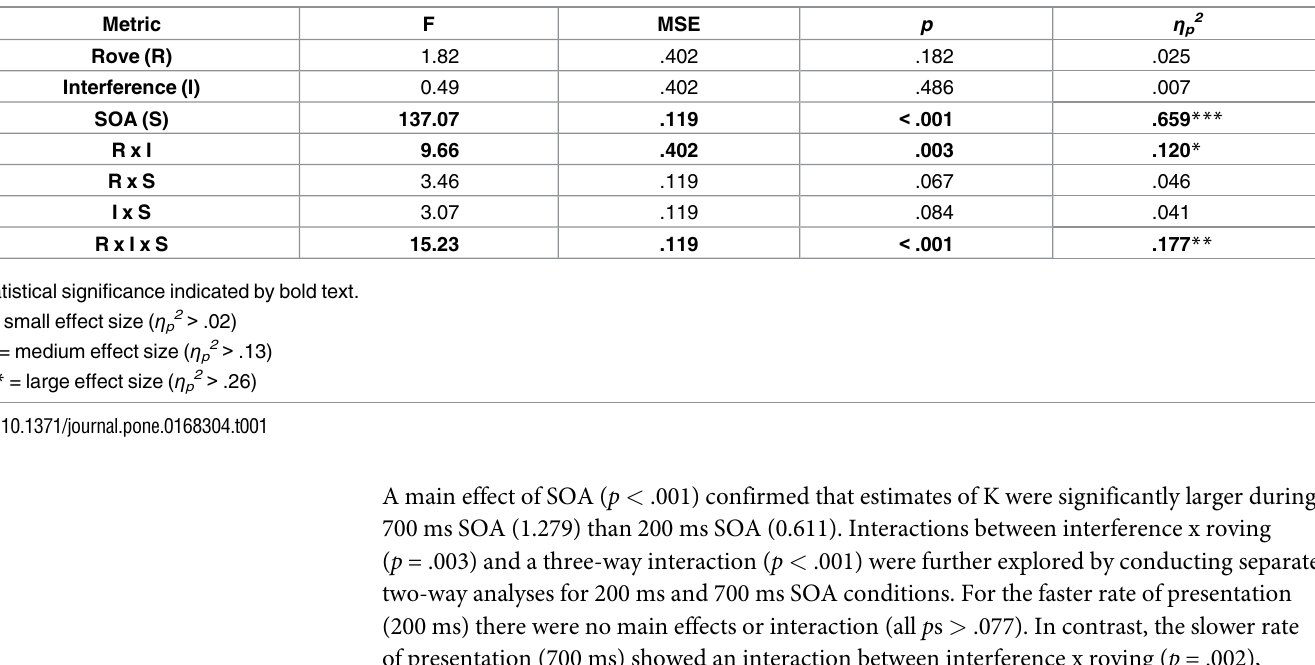
Table 1. Summaryof the three-way mixed model ANOVA comparing estimatesof K across Experiments 1–4 (all df s 1,71). Metric